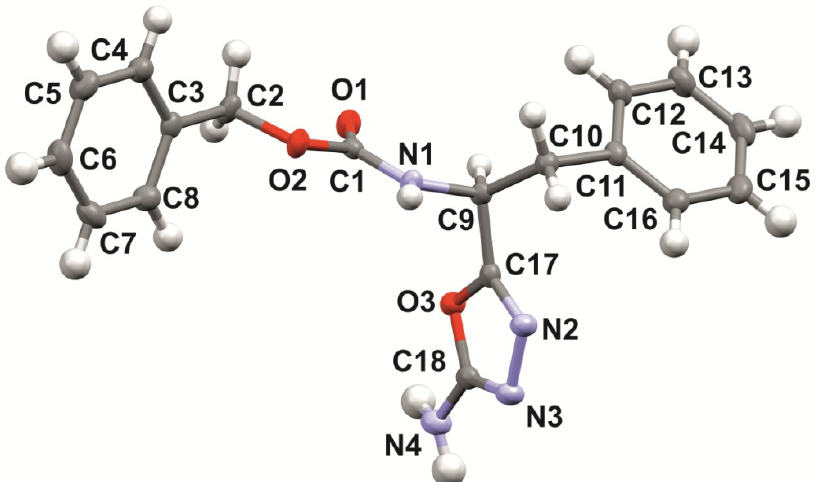
Figure 2. Molecular structure of 2 as represented by the asymmetric unit. Atoms are represented by thermal ellipsoids at the 50% probability